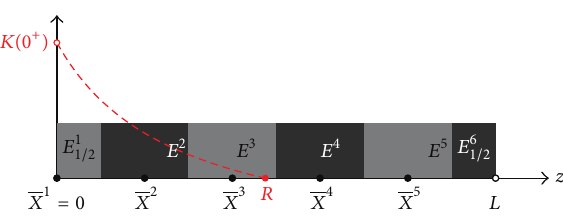
Figure 3: The considered partition of the domain [0,𝐿) is shown in the case 𝑁 = 5 . Solid dots correspond to pedestrian positions. The dashed line portrays an example of interaction kernel 𝐾